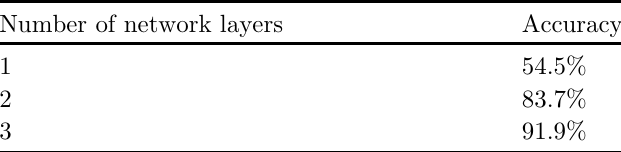
Table 4. The classi fi cation accuracy of different network layer number for test samples.